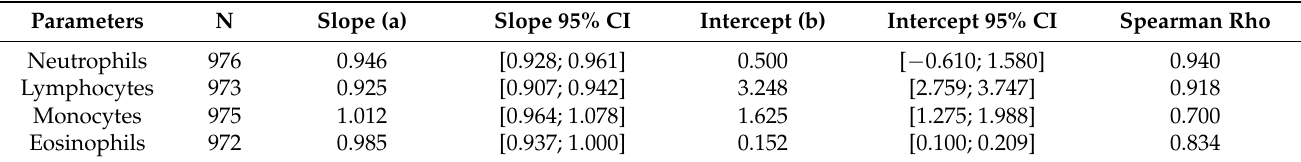
Table 4. Comparison of the DxH 900 results for the leukocyte differential to the reference method (optic microscopy); slope and intercept results for the degree of association for each parameter analyzed DxH 900 = a × Manual Diff + b. Parameters